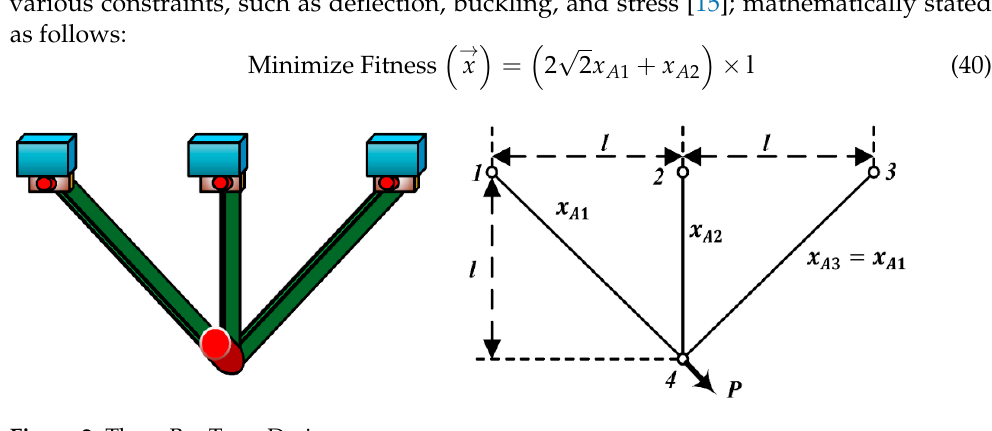
Figure 2. Three-Bar Truss Design.